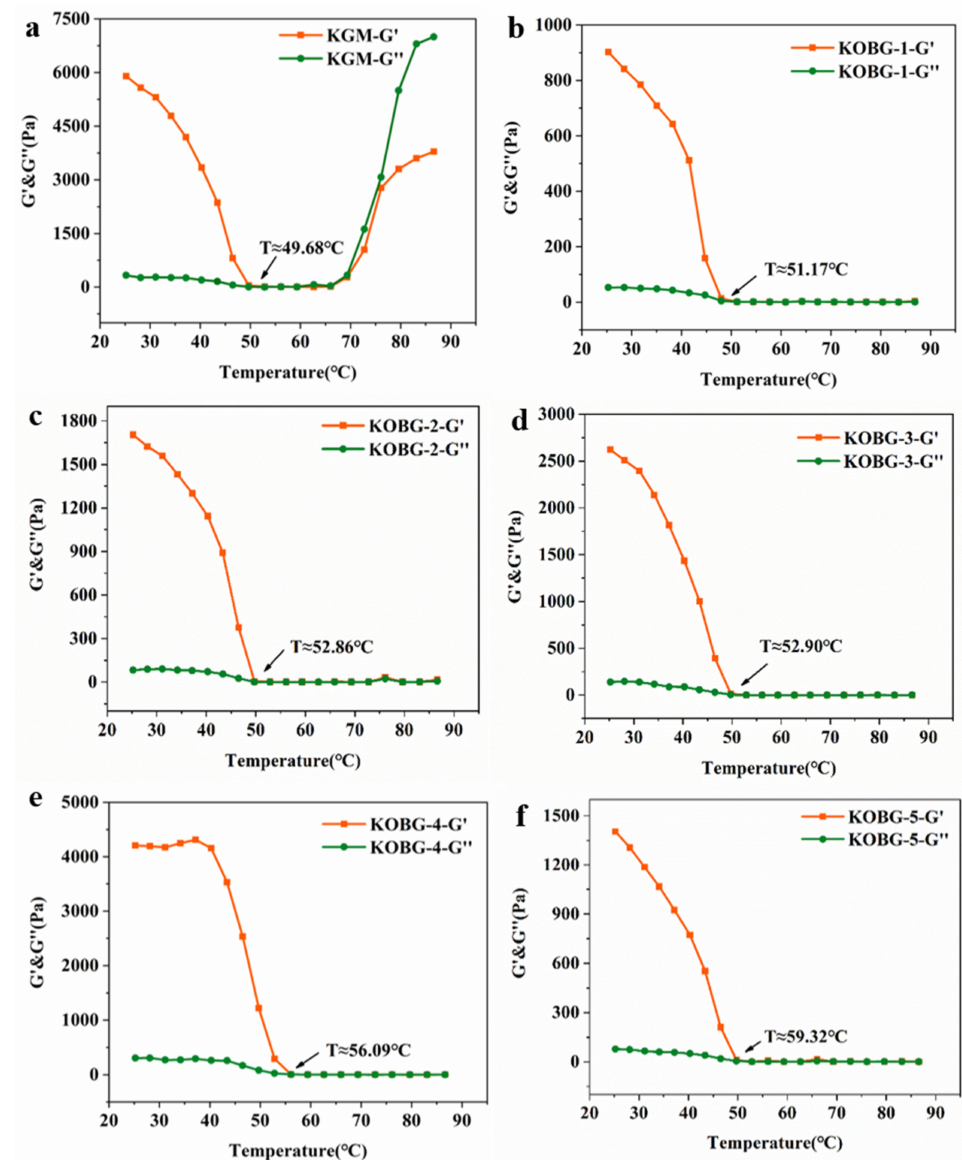
Figure 1. Temperature sweep results of konjac glucomannan (KGM) gel ( a ), KOBG-1 ( b ), KOBG-2 ( c ), KOBG-3 ( d ), KOBG-4 ( e ) and KOBG-5 ( f ). KOBG-1: 1% oat β -glucan; KOBG-2: 2% oat β -glucan; KOBG-3: 3% oat β -glucan; KOBG-4: 4% oat β -glucan; KOBG-5: 5% oat β